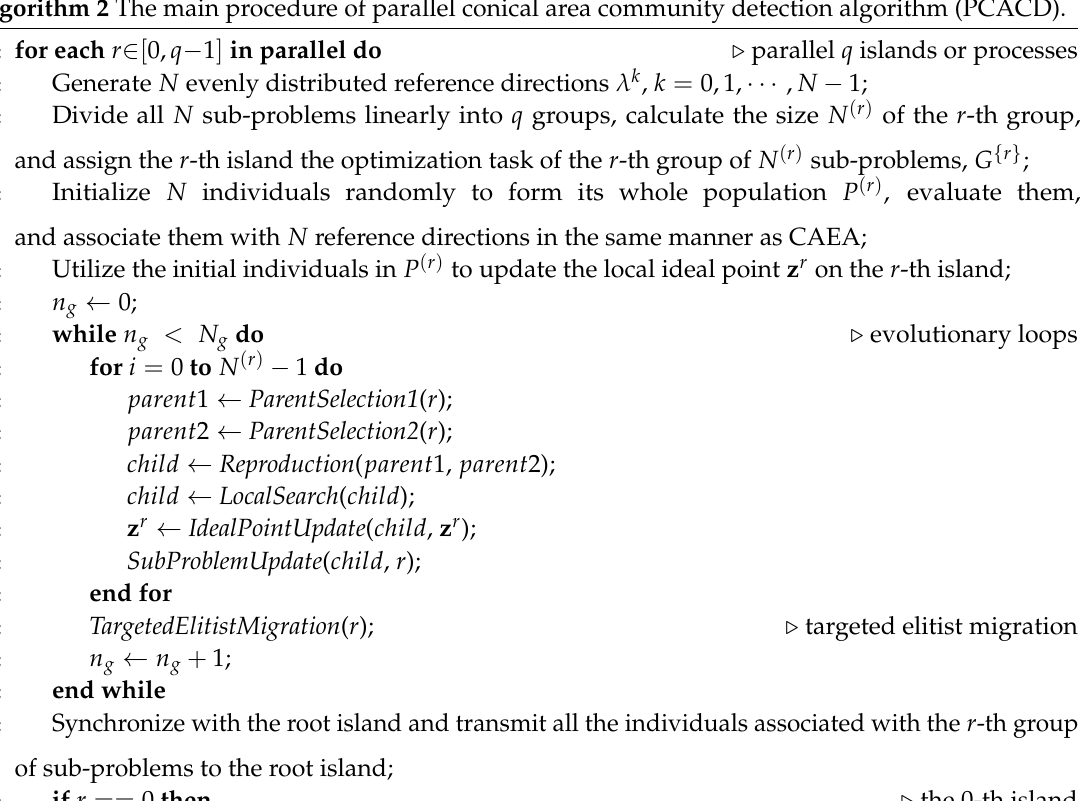
Algorithm 2 The main procedure of parallel conical area community detection algorithm